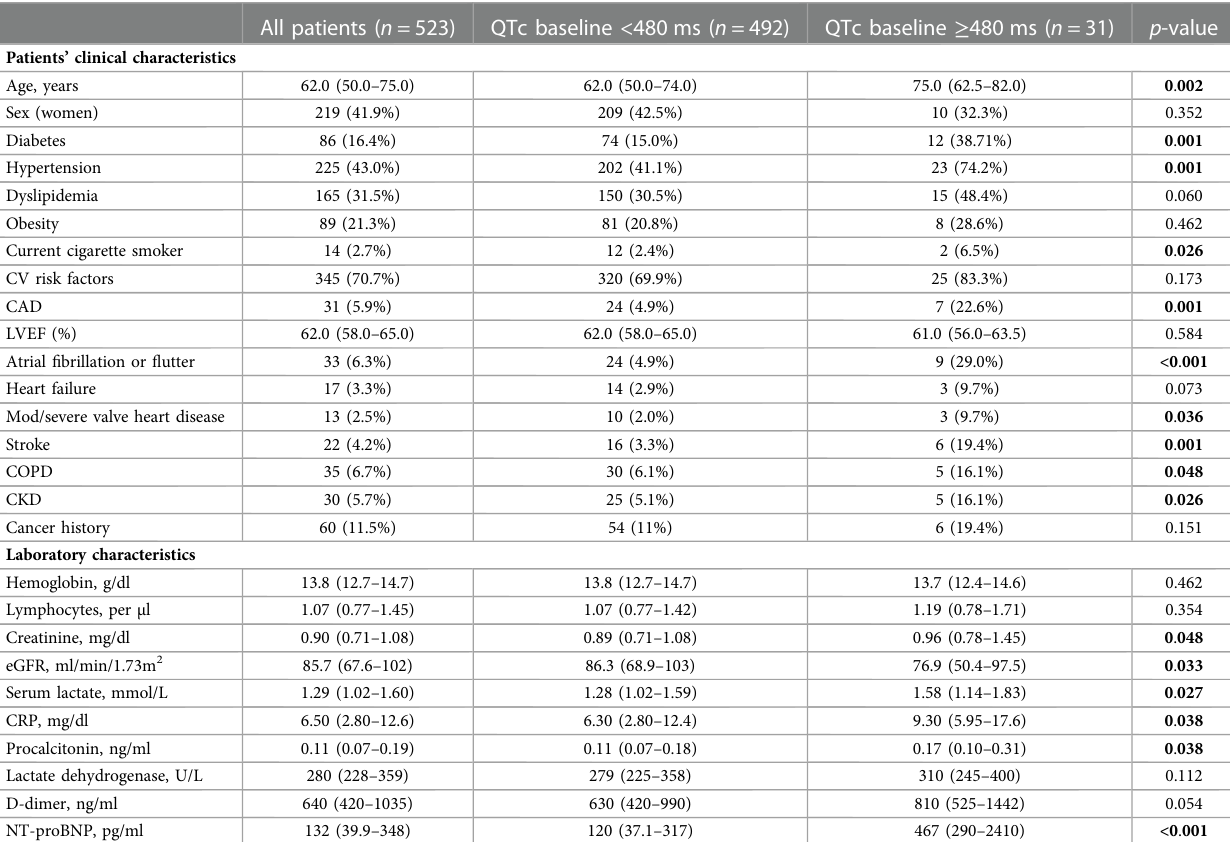
TABLE 1 Comparison of baseline characteristics between hospitalized COVID-19 survivors with and without prolonged QTc on